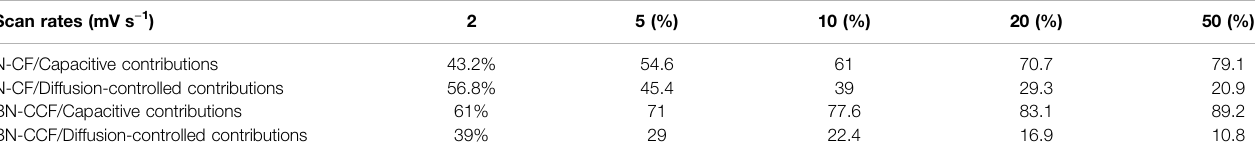
TABLE 4 | Capacitive/diffusion-controlled contributions of N-CF and BN-CCF at different scan rates. Scan rates (mV s − 1 )